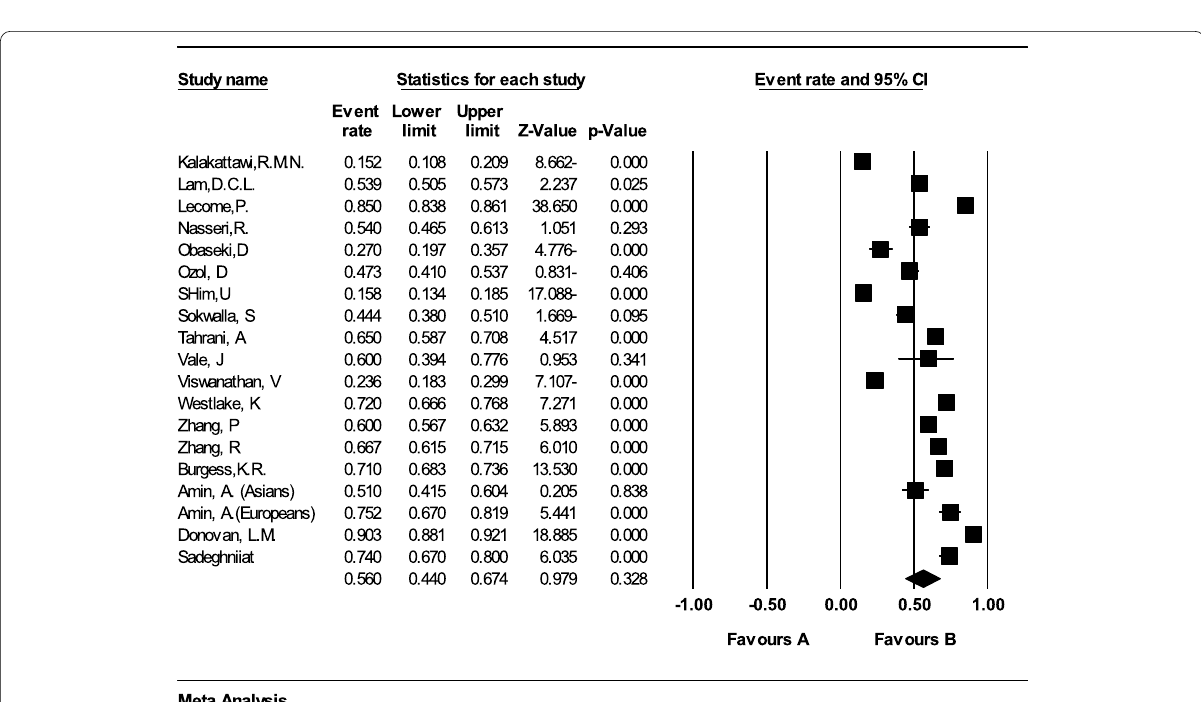
Fig. 3 Forest plot for the prevalence of OSA in type 2 diabetic